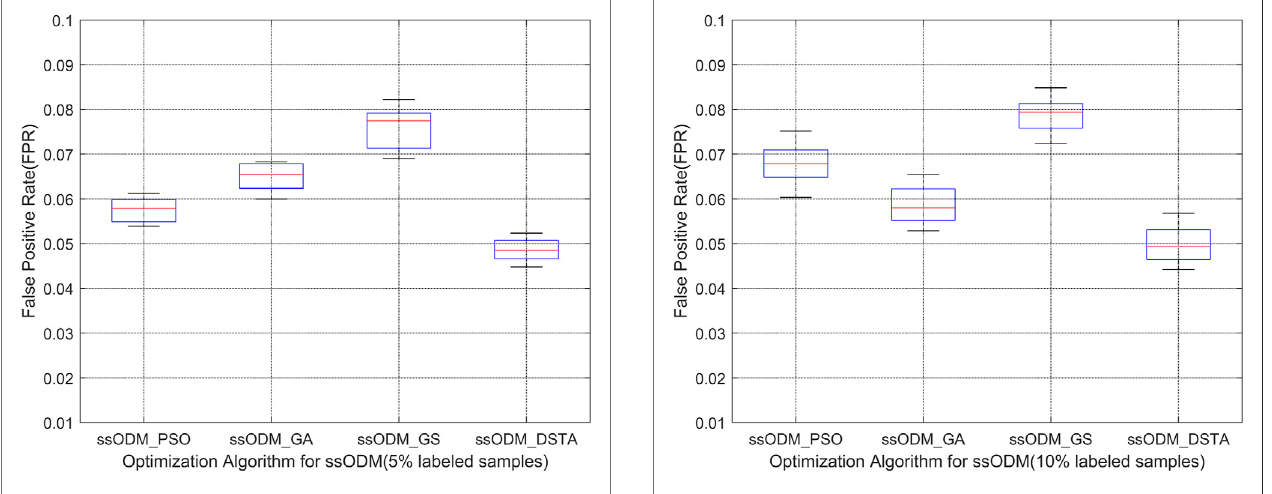
FIGURE 13 | Boxplot of FPR of low-temperature fault detection regarding the blade 2 axle box of the pitch h (10% labeled samples).